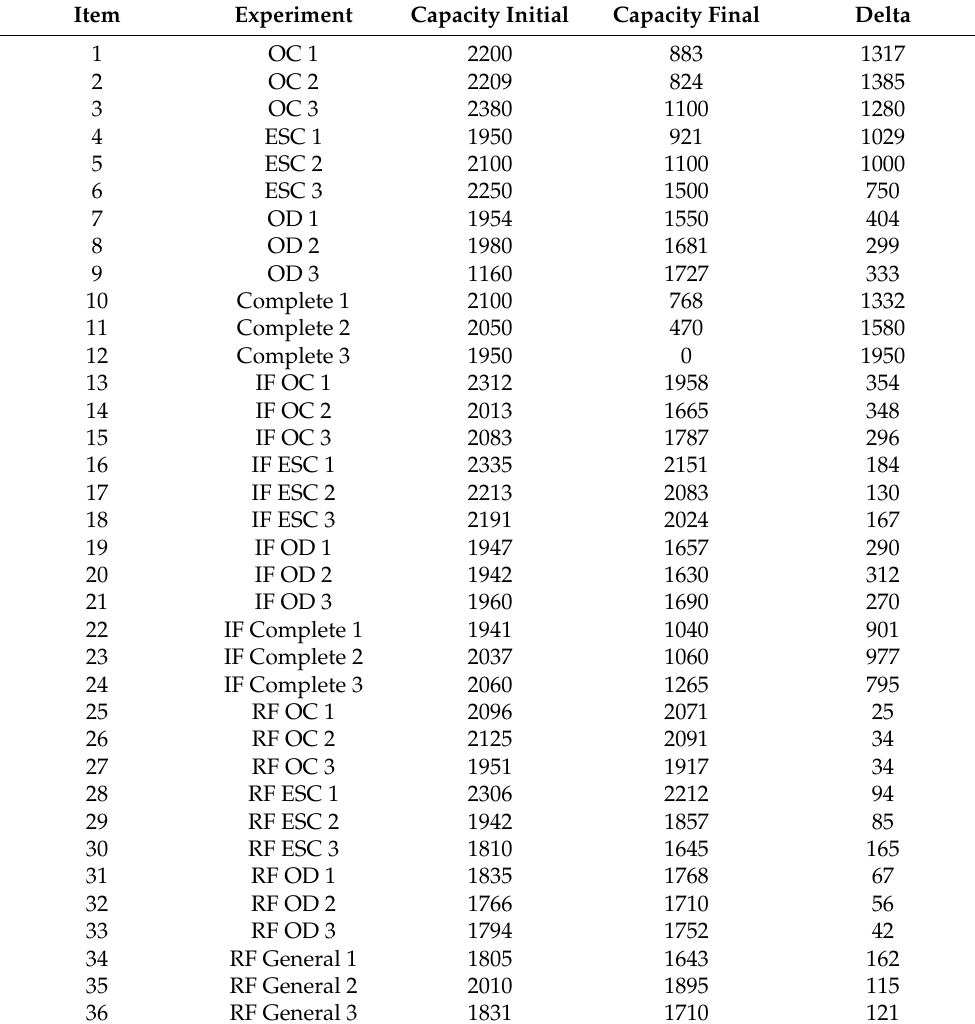
Table 2. Table with the capacity of the cells during, before, and after the